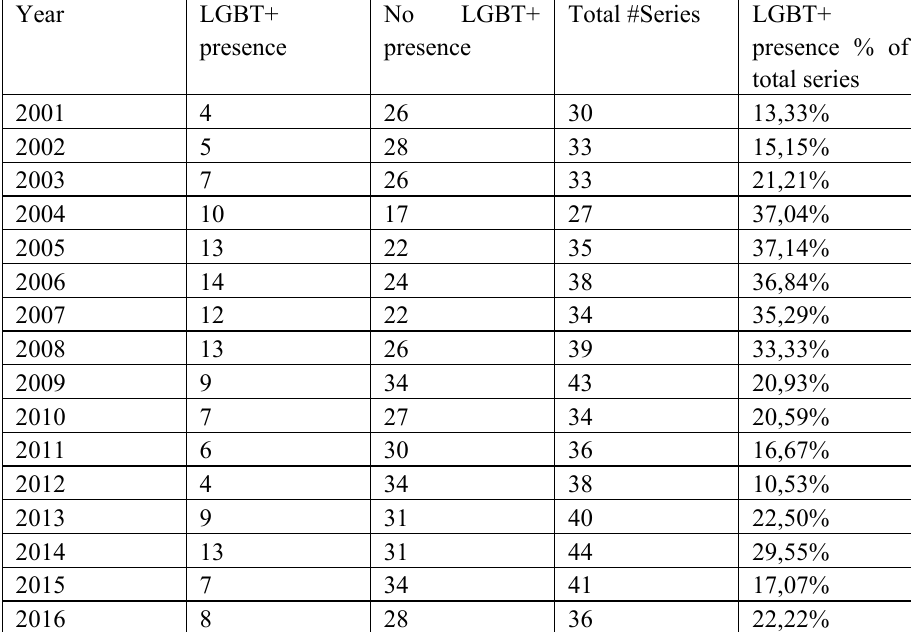
Table 1. Yearly share of broadcast domestic television series with LGBT+ characters Year LGBT+ No presence